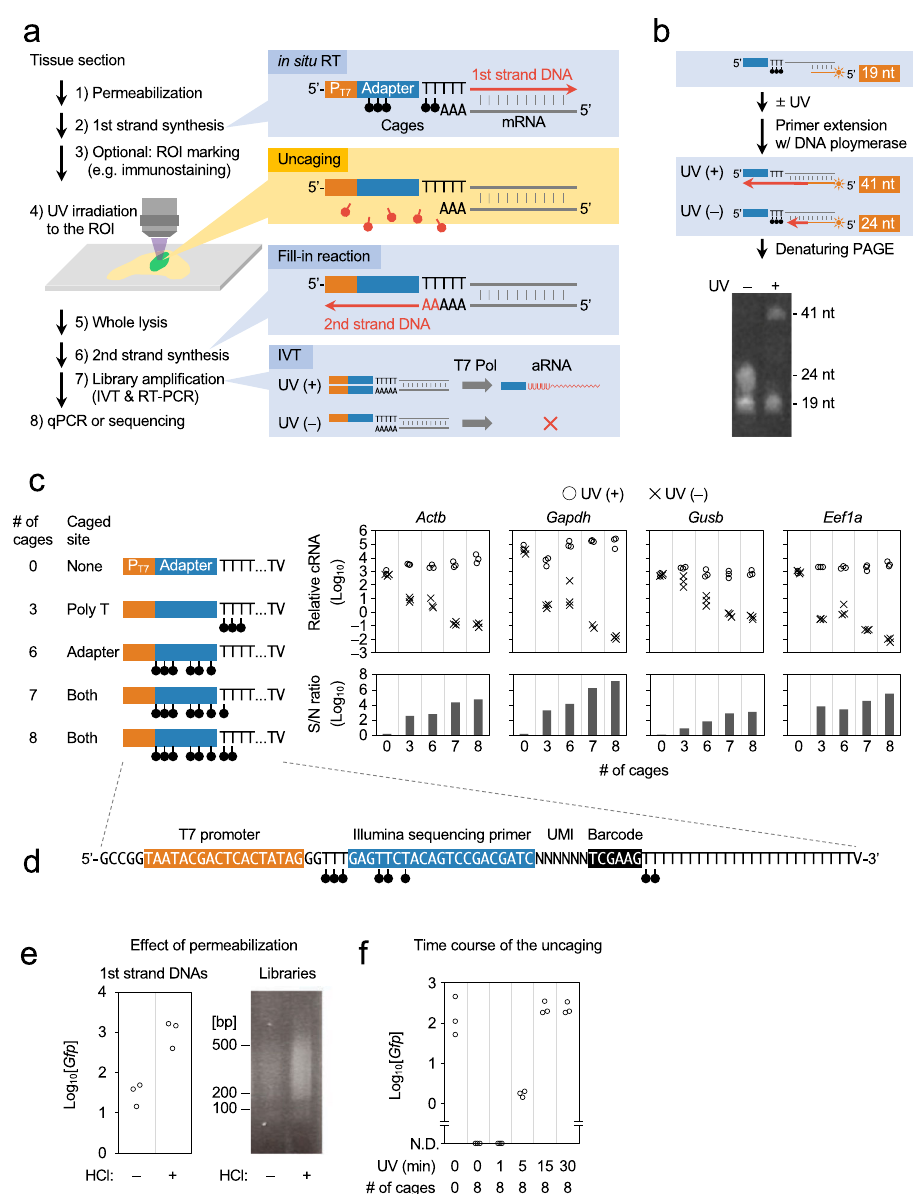
Fig. 1 Establishment of the PIC expression pro fi ling method. a Schematic overview of expression pro fi ling with PIC. P T7 , T7 promoter; T7 Pol, T7 polymerase. b Strategy (top) and the result (bottom) of primer extension experiments to suppress read-through of DNA polymerase I at the NPOM-caged dT sites (black circles) without UV irradiation. A representative image was shown out of three independent experiments. c Various caged ODNs were examined for RNA-seq library preparation with (circles) or without (crosses) photo-irradiation before quantifying the expression of Actb , Gapdh , Gusb, and Eef1a genes. d Sequence of the caged ODN showing the lowest background in ( c ). e Effect of HCl permeabilisation before in situ RT in GFP-expressing NIH/ 3T3 cells was evaluated by the yield of Gfp cDNA (left) and the size (right) of sequence libraries. A representative image was shown out of three independent experiments. f GFP-expressing NIH/3T3 cells were photo-irradiated for various times after in situ RT, and the yield of Gfp cDNA was quanti fi ed. Source Data is available as a Source Data fi